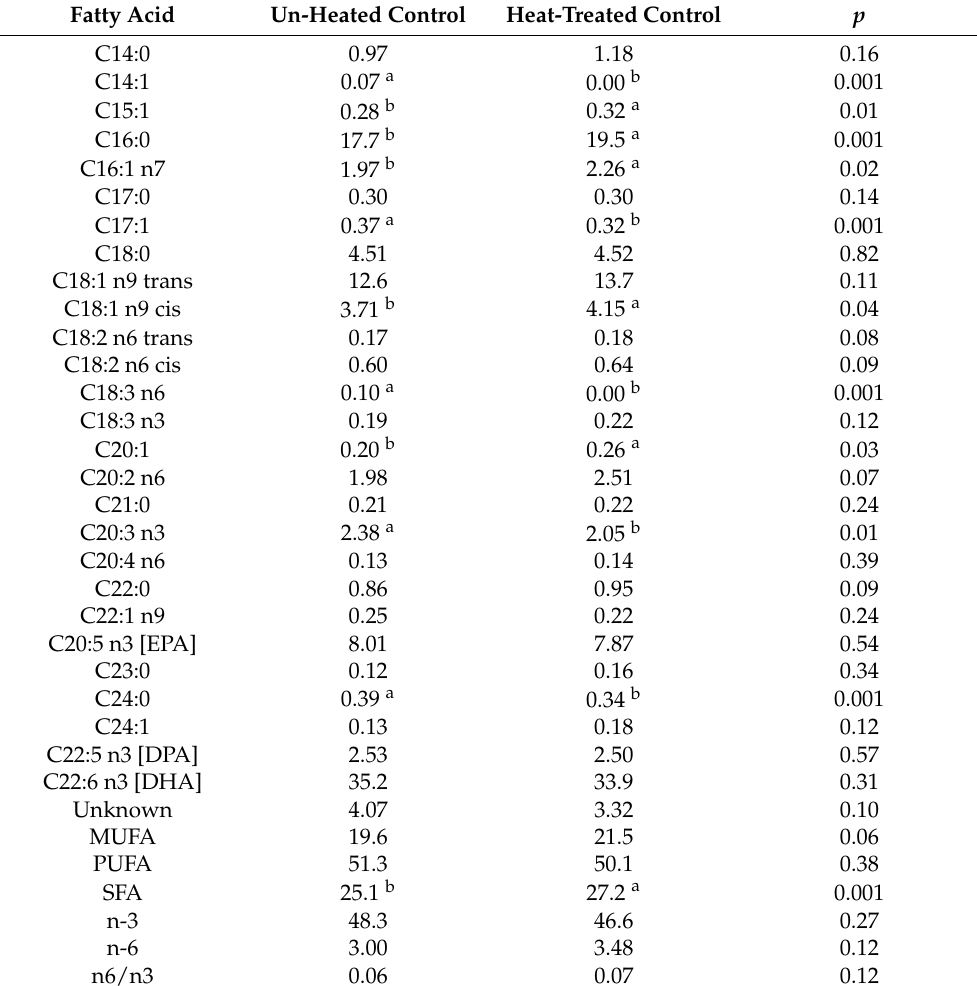
Table 3. Fatty acid composition of total lipid extracted from HMG. Fatty Acid Un-Heated Control Heat-Treated Control p